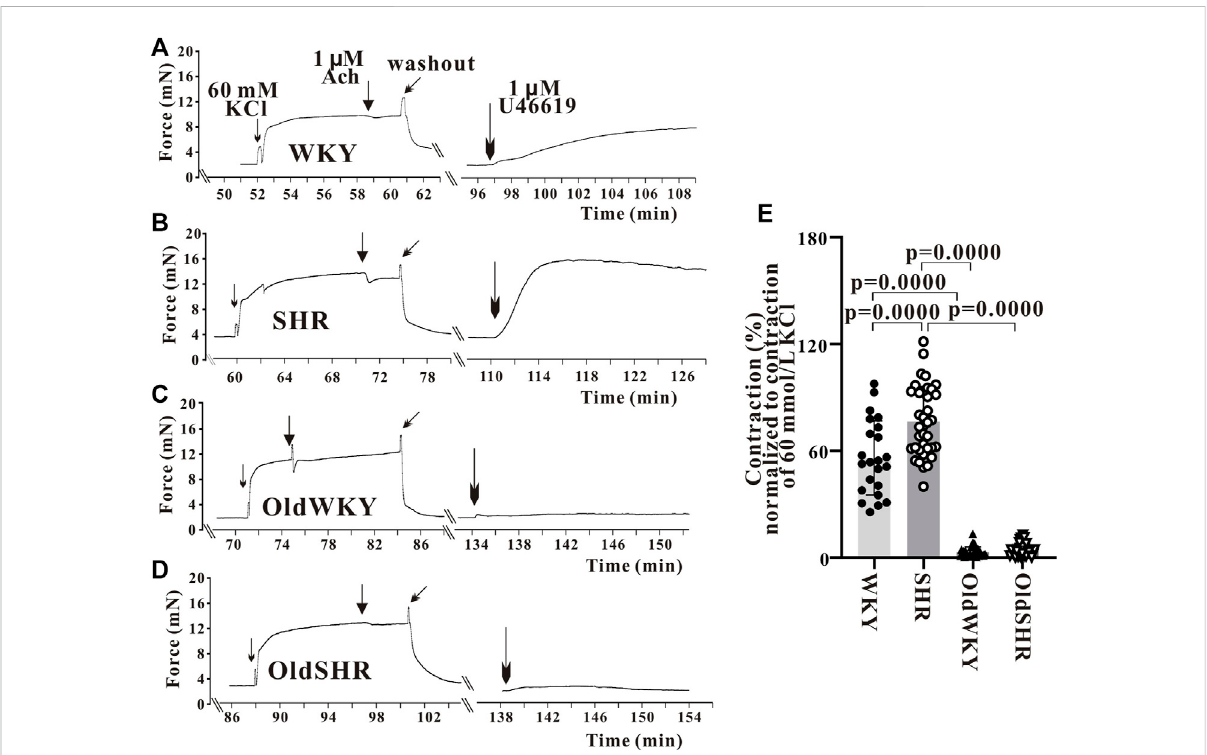
FIGURE 2 U-46619inducedthecontractionofendothelium-denudedmesentericarteryrings. (A – D) Typicalrecordingsshowingvesselresponseto1 μ M U-46619 inthefour groups. The X-coordinate time wasrecordedfrom thetime whenthevascularringpassed theactivitytestand wasstabilizedfor another 30 min. (E) Summarydata showing that mesenteric artery response to U-46619 was diminished remarkably in OldWKY and OldSHR groups. Mesenteric vessels were obtained from 16 WKY rats, 9 SHR rats, 17 OldWKY rats, and 18 OldSHR